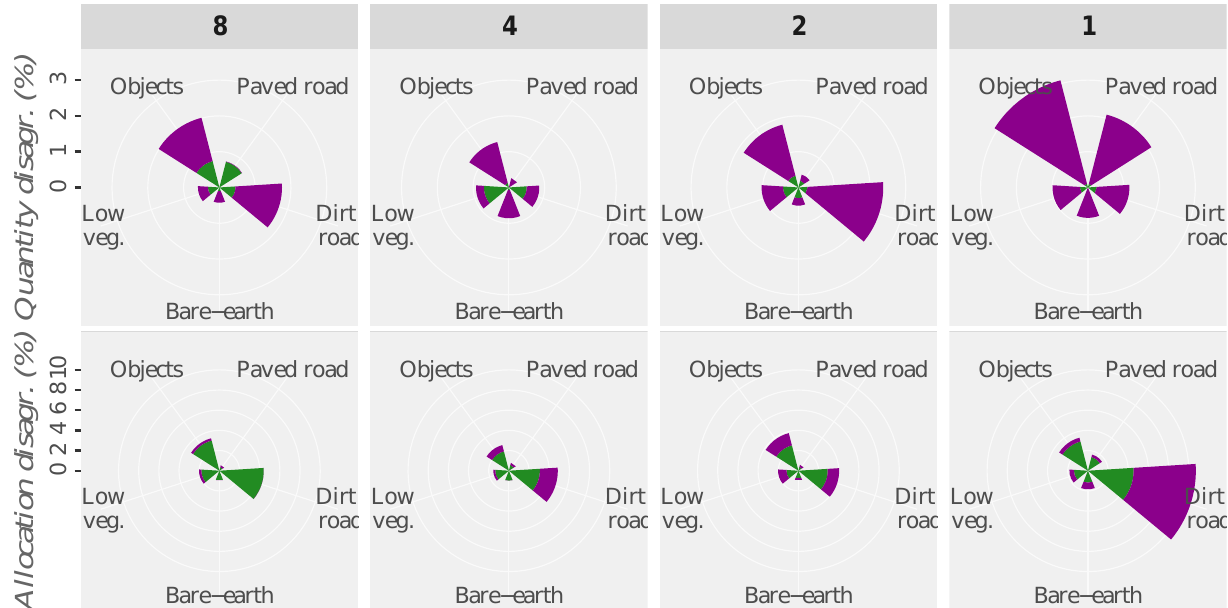
Figure 11. Hybrid vs. RF: Disagreement (%) for point clouds with densities of 8 (first column), 4 (second column), 2 (third column) and 1 (last column) point/m 2